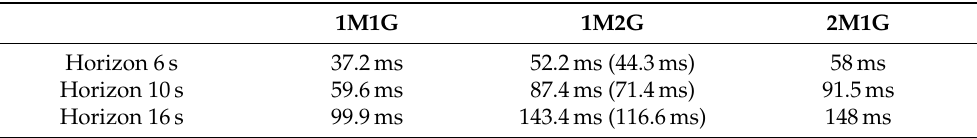
Table 5. Average solving time of the algorithm for different prediction horizons in the car- following scenario using V2V-prediction. Values in braces belong to the relaxed optimization of the 1M2G-topology. 1M1G